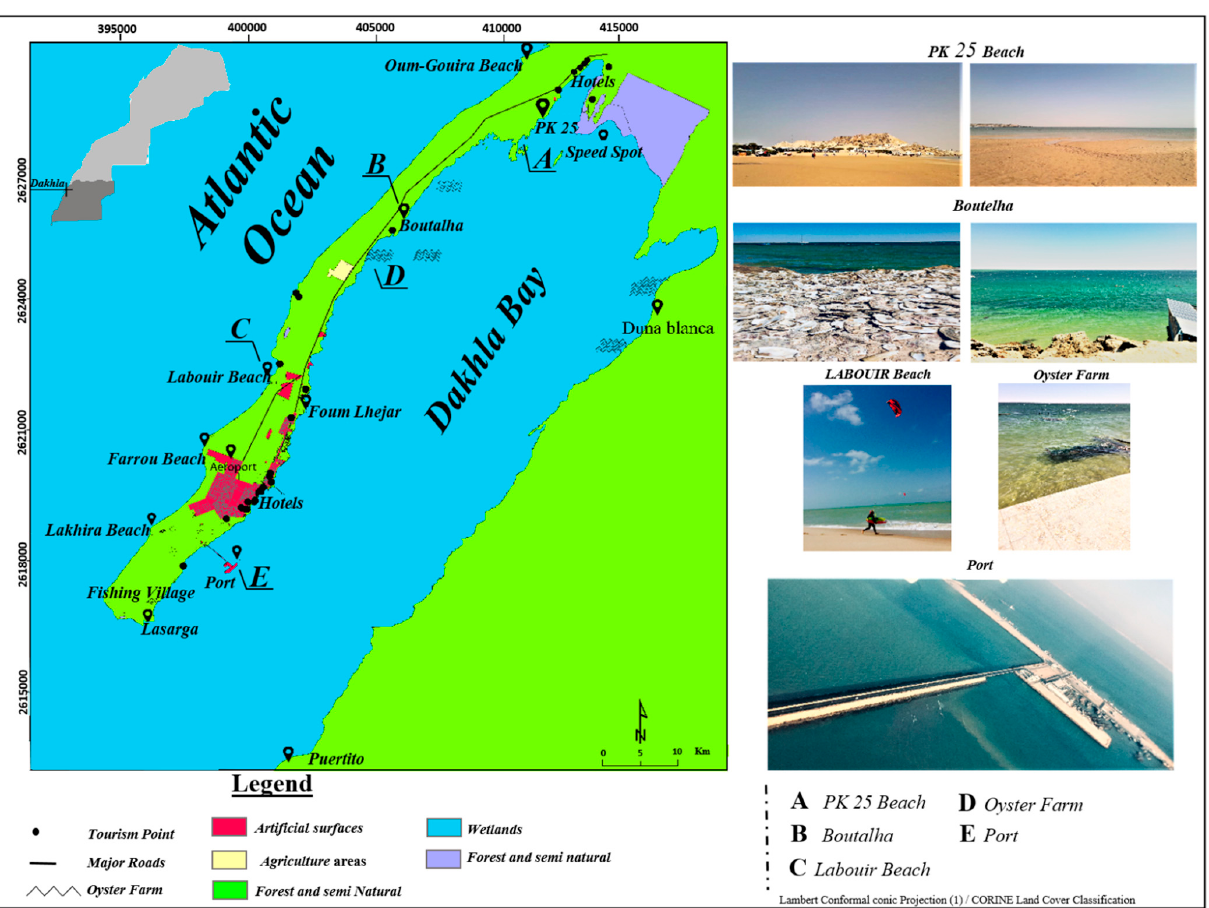
Figure 1. Land cover and tourist